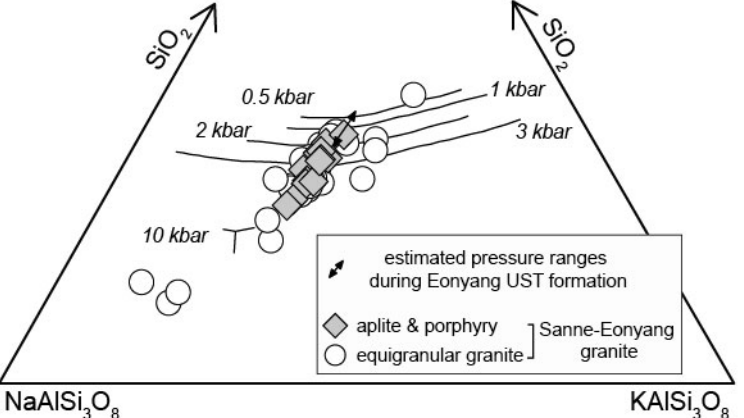
Figure 9. Normative mineralogy in the Sannae-Eonyang granite calculated from major element com- positions [26,36,37] are plotted in a quartz–alkali-feldspar–plagioclase ternary (QAP) diagram. We applied the eutectic-cotectic information [54–56] and plotted a possible pressure range (820–2200 bars) estimated from the fluid inclusion analysis.